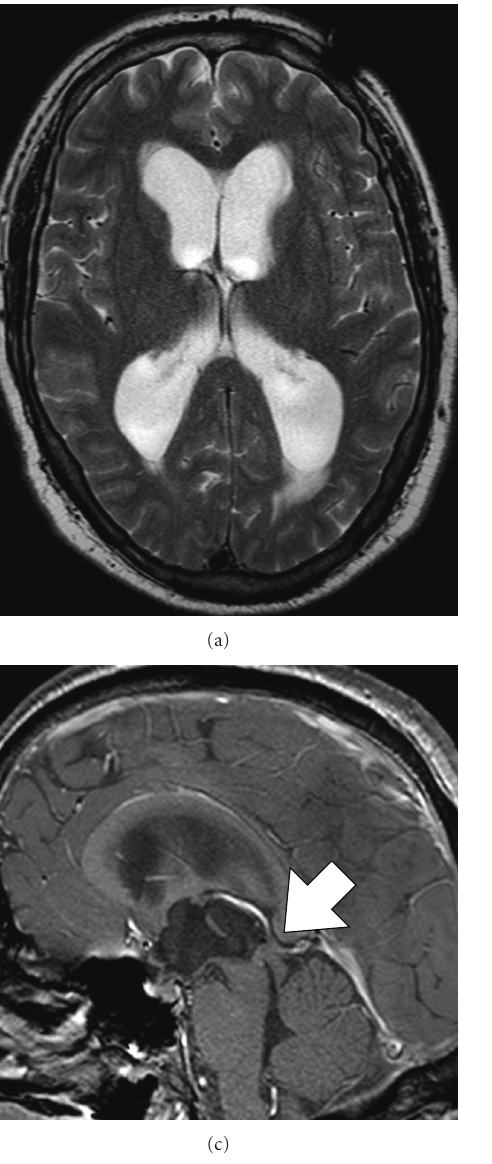
Figure 1: (a) T2-weighted MRI showing marked hydrocephalus, T1-weighted contrast enhanced MRI reveals a small lesion tumor at the cranial end of the aqueduct in axial (b) and sagittal view (c) and TRUFI sequences (sagittal thin T2-weighted images,